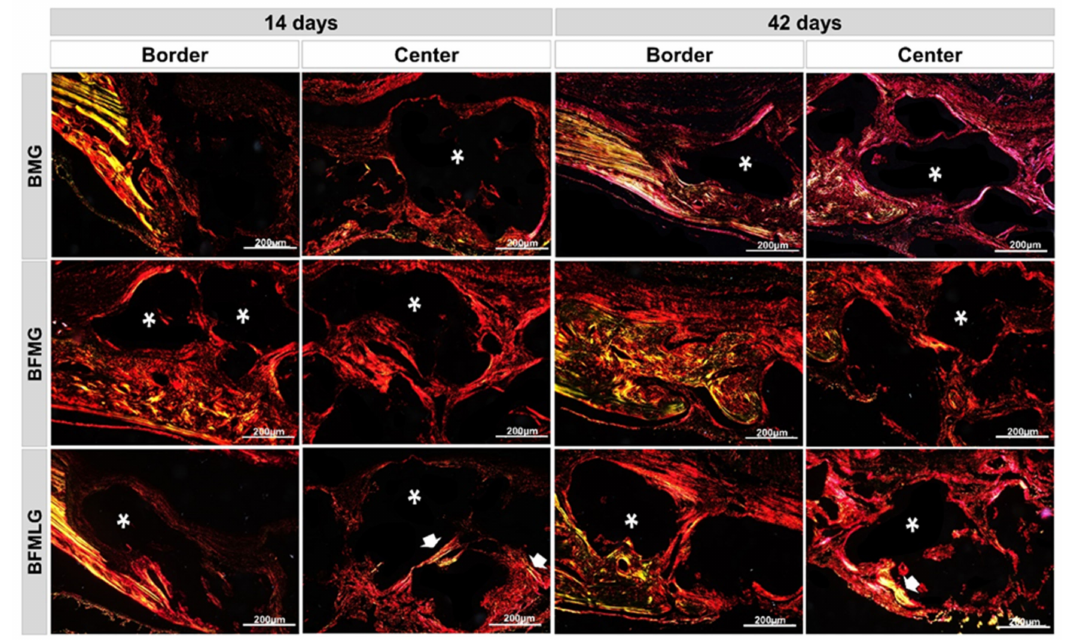
Figure 6. Histological sections of the border and center of the bone defect of rat calvaria stained by Picrosirius-red under polarized light at 14 and 42 days. BMG—defects filled with HA/ β -TCP covered by a bovine biological membrane; BFMG defects filled with HA/ β -TCP and heterologous fibrin biopolymer covered with bovine biological membrane; BFMLG defects filled with HA/ β -TCP and heterologous fibrin biopolymer covered with bovine biological membrane and PBMT. RGB green-yellow-red colors. Mature bone—yellowish-green fibers (white arrow); immature bone—orange-red; particles of the biomaterial (dark background—asterisk). Original 10 × magnification, 200 µ m scale